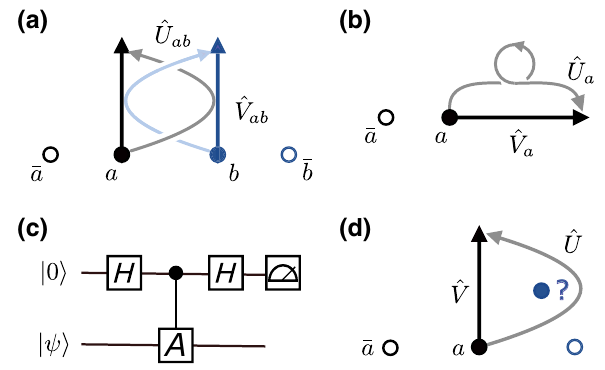
FIG. 5. Probing braiding statistics by interferometry. The uni- tary paths ˆ V and ˆ U for obtaining (a) S ab and (b) the twist